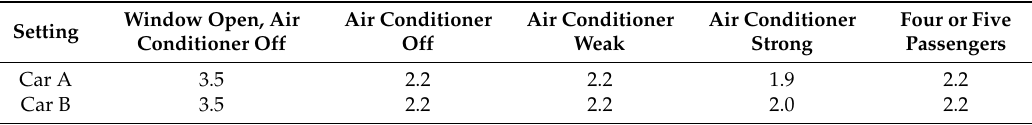
Table 5. Measured sharpness [acum] for Experiment